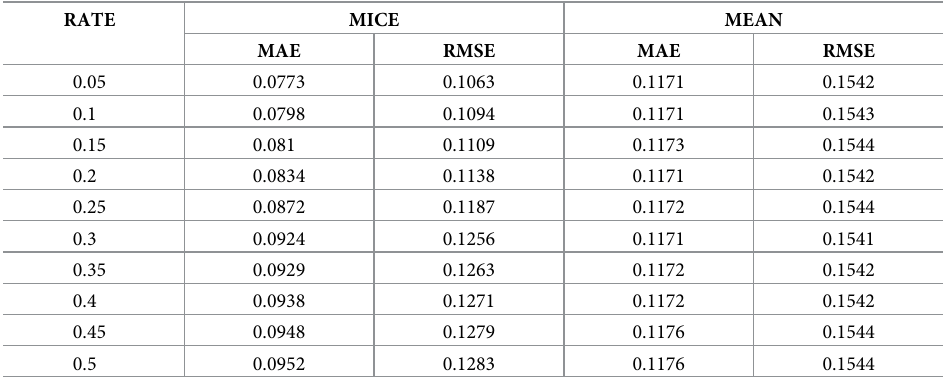
Table 3. The overall MAE and RMSE.